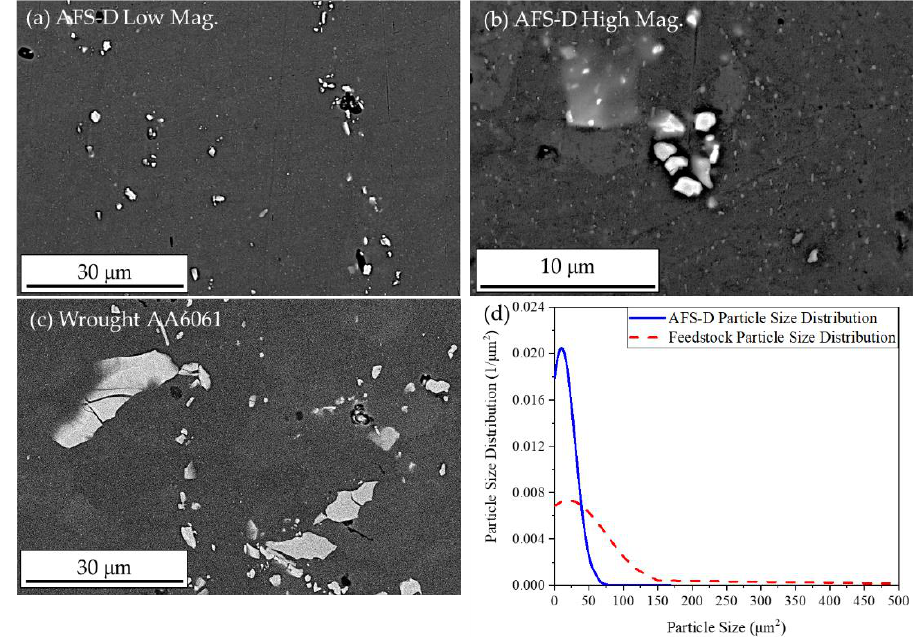
Figure 3. ( a ) AFS-D back-scatter electron (BSE) image showing iron-rich particles generally spherical in nature, ( b ) 5000 × magnification BSE image of a cluster of particles in the AFS-D, ( c ) wrought AA6061-T651 feedstock BSE image with larger, amorphous iron intermetallic particles, and ( d ) a normal distribution contrasting the sizes of the iron particles in the AFS-D and feedstock materials. Table 1. Average and standard deviation from particle distribution for wrought and as-deposited AFS-D AA6061. Material AFS-D ( µ m) Average Particle Size